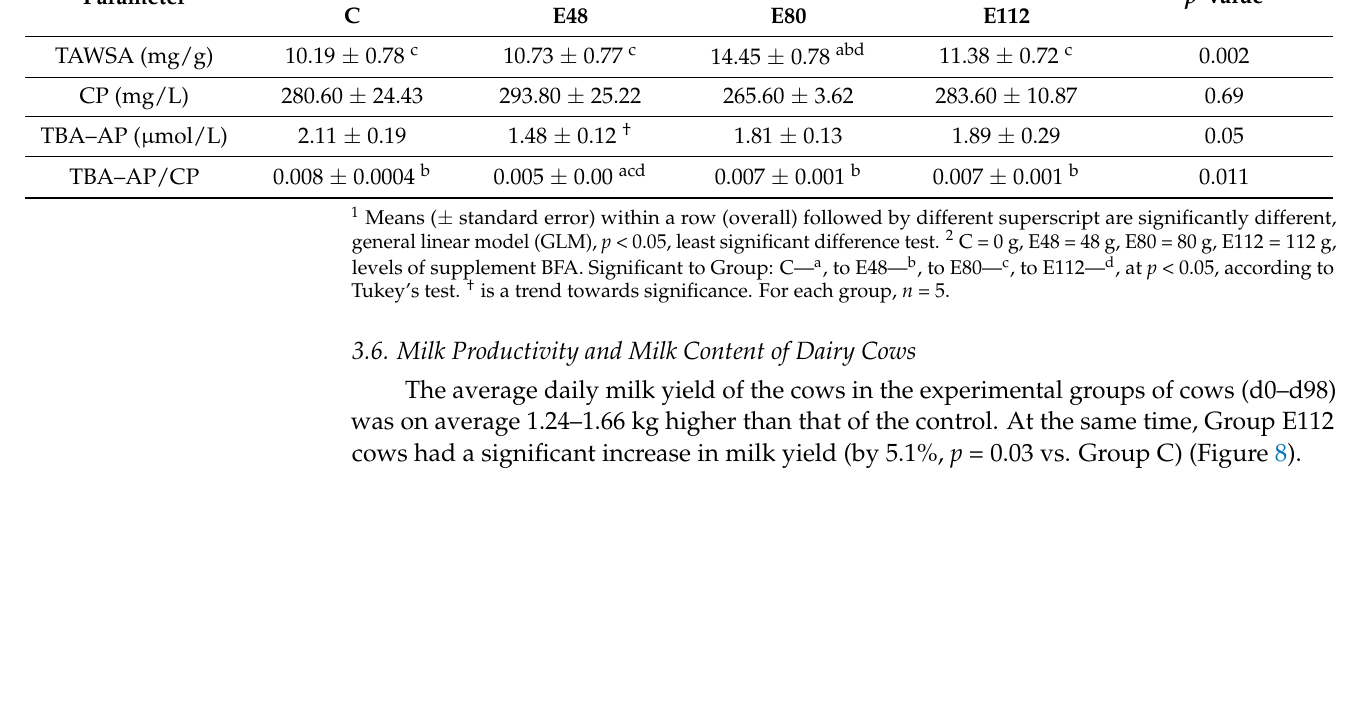
Table 6. Biochemical and morphological parameters of the blood at the end of the experiment (d98) 1 .